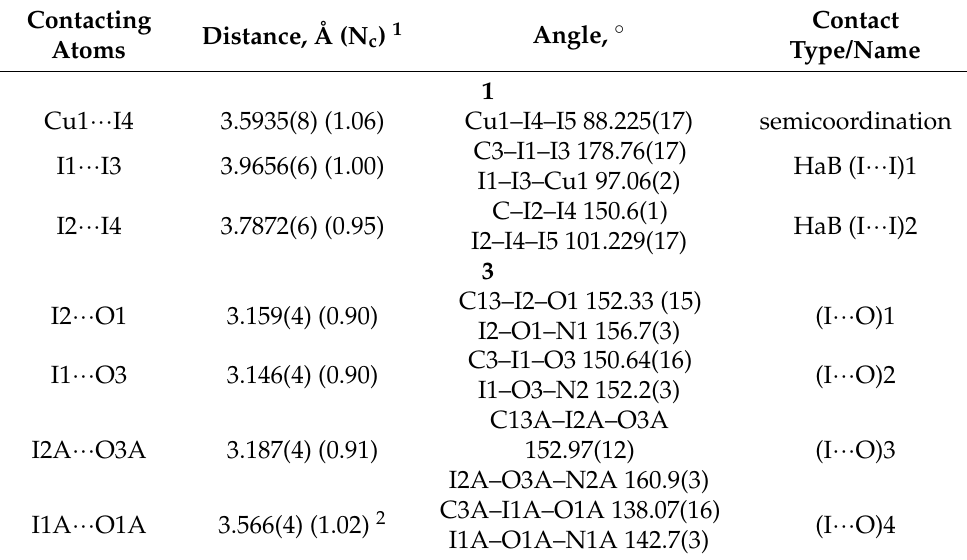
Table 3. Selected noncovalent interactions in the Cu II